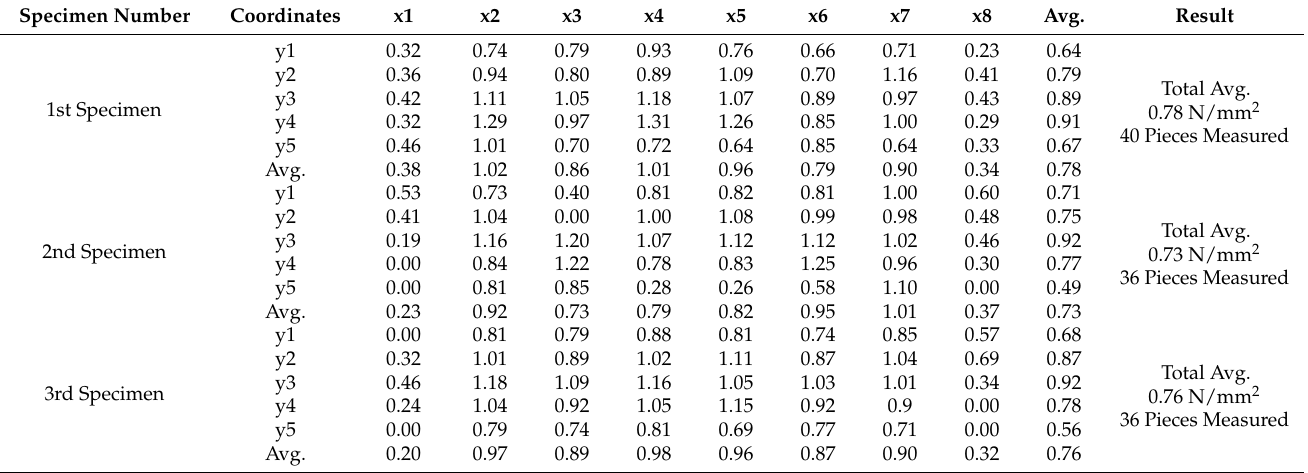
Table 9. AR 100% specimen result.